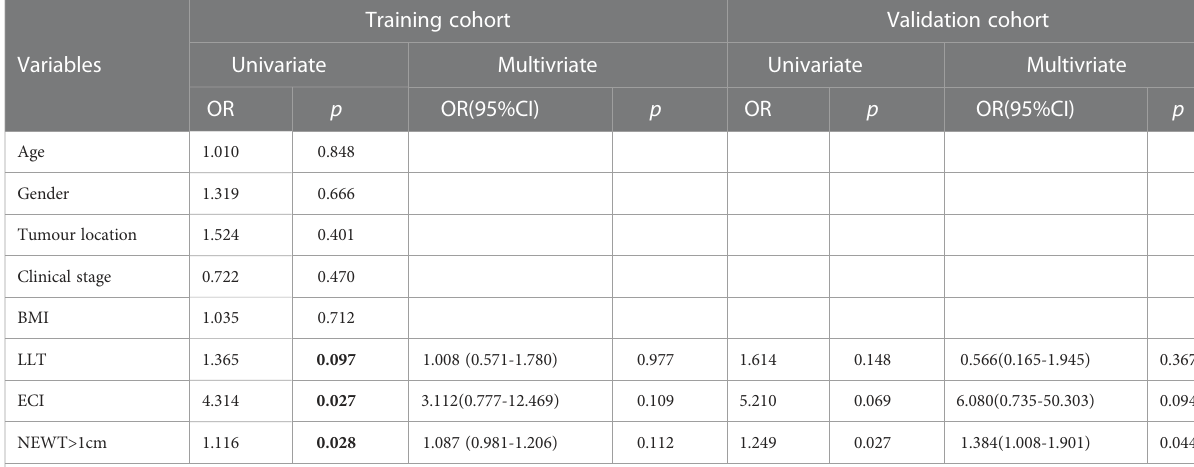
TABLE 2 Univariate and multivariate association of Rad-score and clinical characteristic Logistic regression analysis of BES (likelihood Ratio: Backward stepwise).